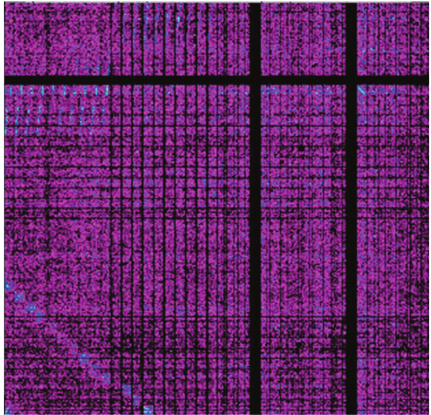
Figure 17: Image, due to the cosmic rays, acquired by the OFFSET